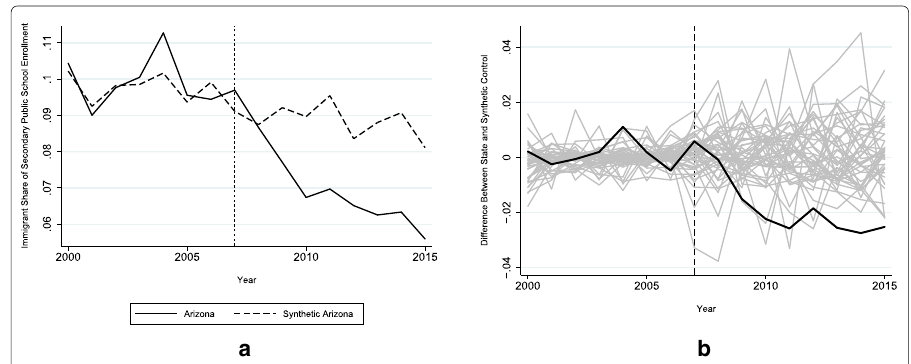
Fig. 8 LAWA and share of immigrants in public secondary school. a Share of immigrants. b Permutation test